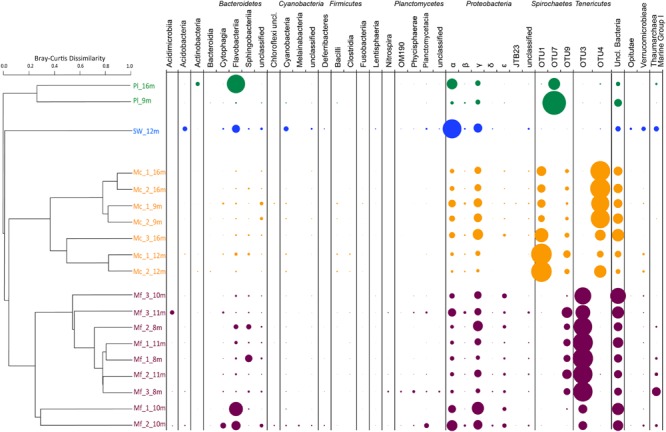
Bray–Curtis Dissimilarity Indices as hierarchical clustering dendrogram. Microbiomes summarized as taxa at the Class level per sample. Bubble size indicates relative abundance of taxa within a sample. Pl: Parazoanthus lucificum, SW: sea water, Mc: Muricea californica, Mf: Muricea fruticosa. Sample names are “species_biological replicate_depth of collection”.